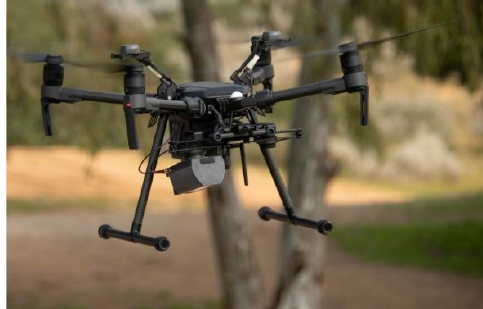
Figure 3. I nstruments used during the survey’s campaigns.